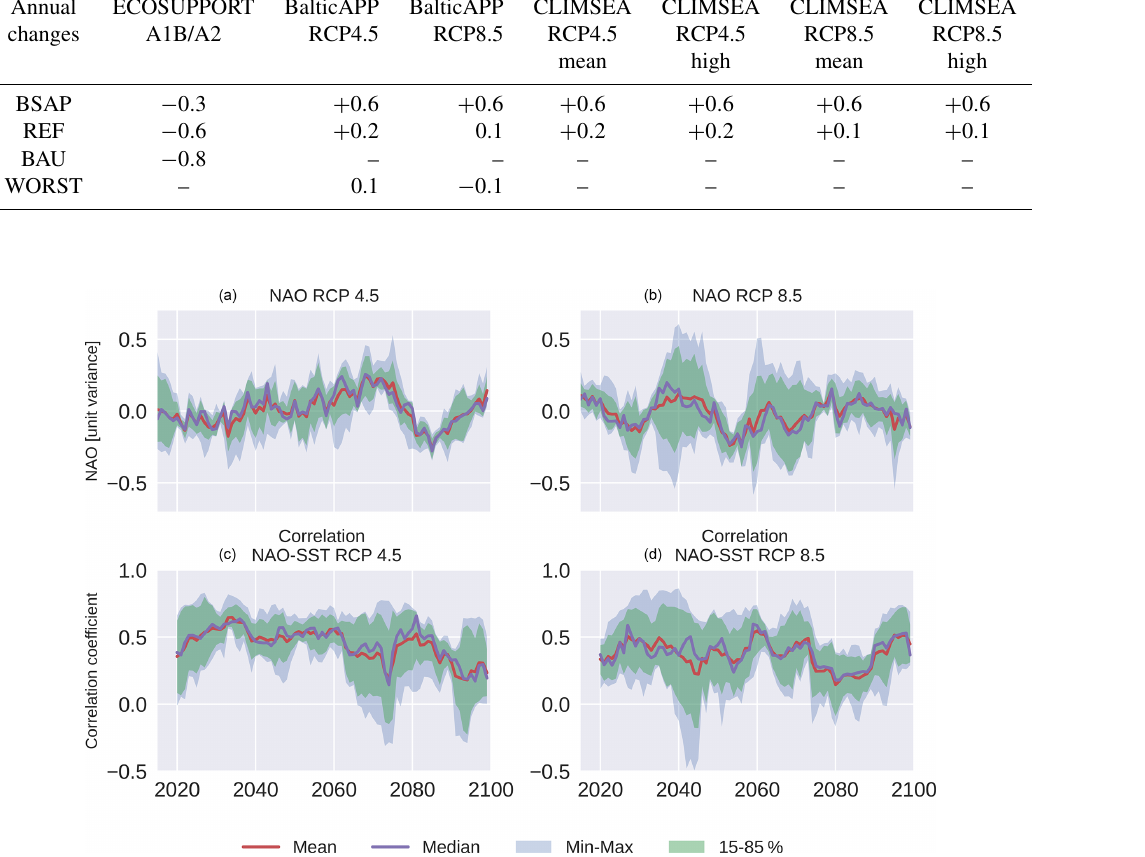
Figure 26. Ensemble 10-year running mean North Atlantic Oscillation (NAO) index (a, b) and 10-year running correlation between the NAO and area-averaged SST in the Baltic Sea (c, d) under the RCP4.5 (a, c) and RCP8.5 (b, d) scenarios. Depicted are winter (December– February) mean, median, minimum, maximum and 15th and 85th percentiles. (Data source: Meier et al.,